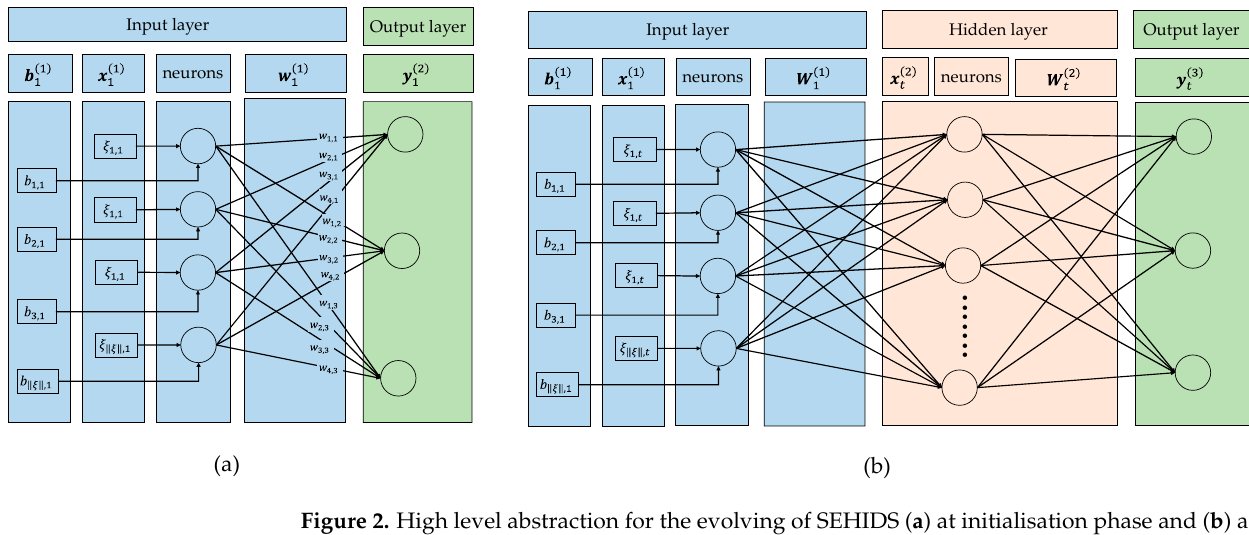
Figure 2. High level abstraction for the evolving of SEHIDS ( a ) at initialisation phase and ( b ) after elapsing some time 𝑡 . Algorithm 1: pseudocode of